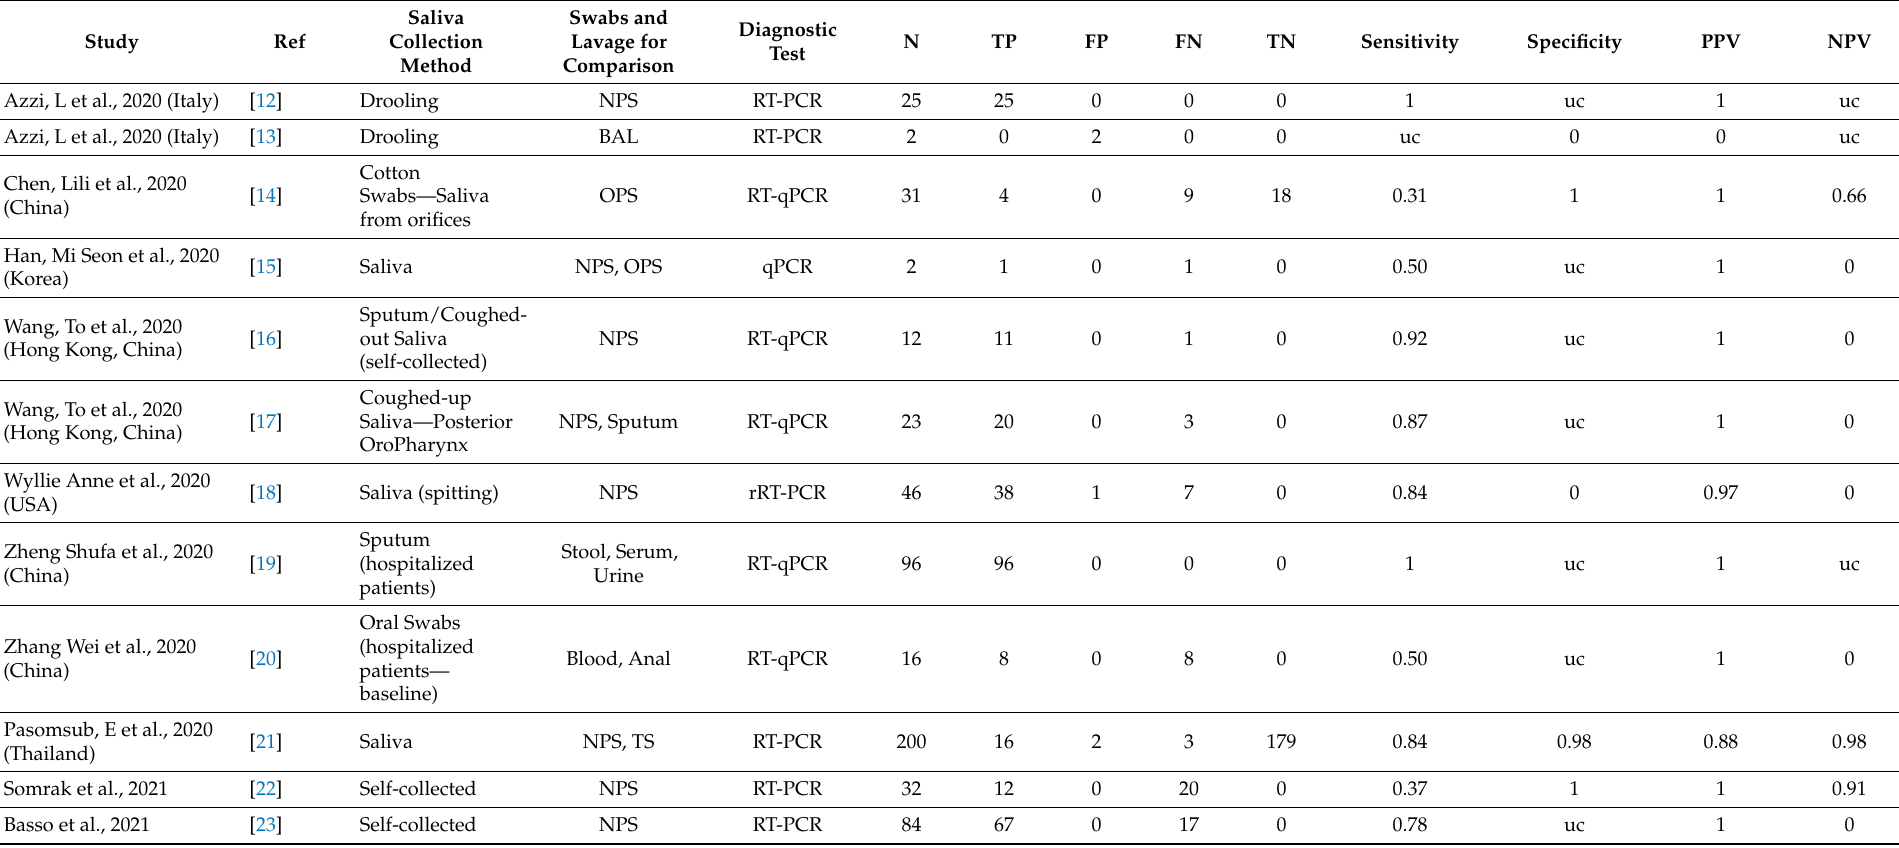
Table 2. Comparison of studies using saliva-based testing versus conventional swab-based testing for the detection of